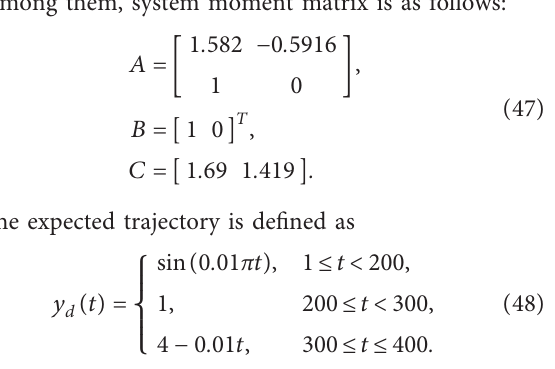
Figure 1: Control and design of algorithm step-by-step